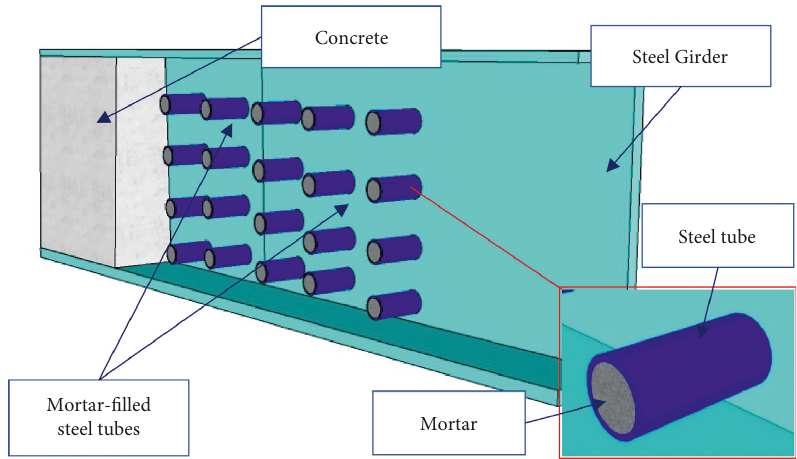
Figure 23: Steel tube shear connector filled by mortar in a perforated steel plate.